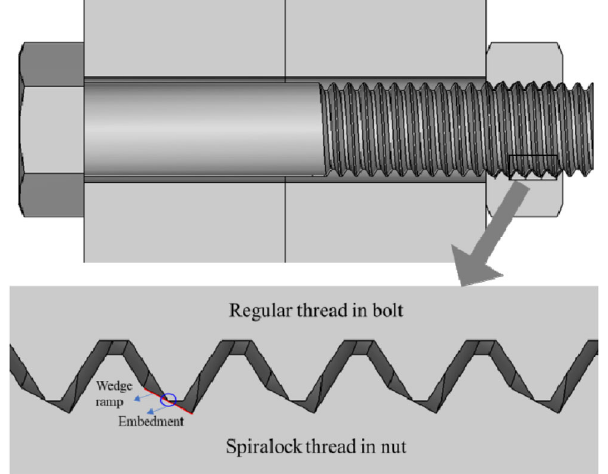
Fig. 24 Schematic of engagement between regular thread in bolt and Spiralock thread in nut.